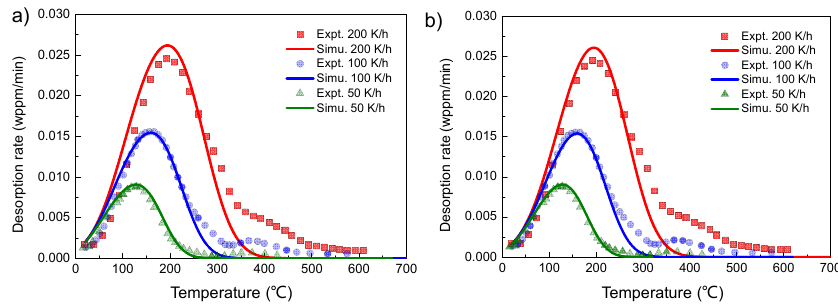
Figure 2. Comparison of the simulated thermal desorption spectra (TDS) curves with the experimental data reported in Reference [22], using two different values of rest time: ( a ) t r = 3 h and ( b ) t r = 5 h. Other parameters used in the simulation were: E d = Q − ∆ H = − 25 kJ/mol, Q = − 4.15 kJ/mol, D 0 = 5.1 × 10 − 8 m 2 /s. The rod specimen was considered with a diameter D = 6.3 mm and height H = 25 mm. By finding a best fit with the experimental data, different combinations of N T / N L = 8.0 × 10 − 2 , = 3.0 × 10 − 7 and N = 7.5 × 10 − 2 , θ 0 = 3.6 × 10 − 7 were used in ( a , b ), respectively.